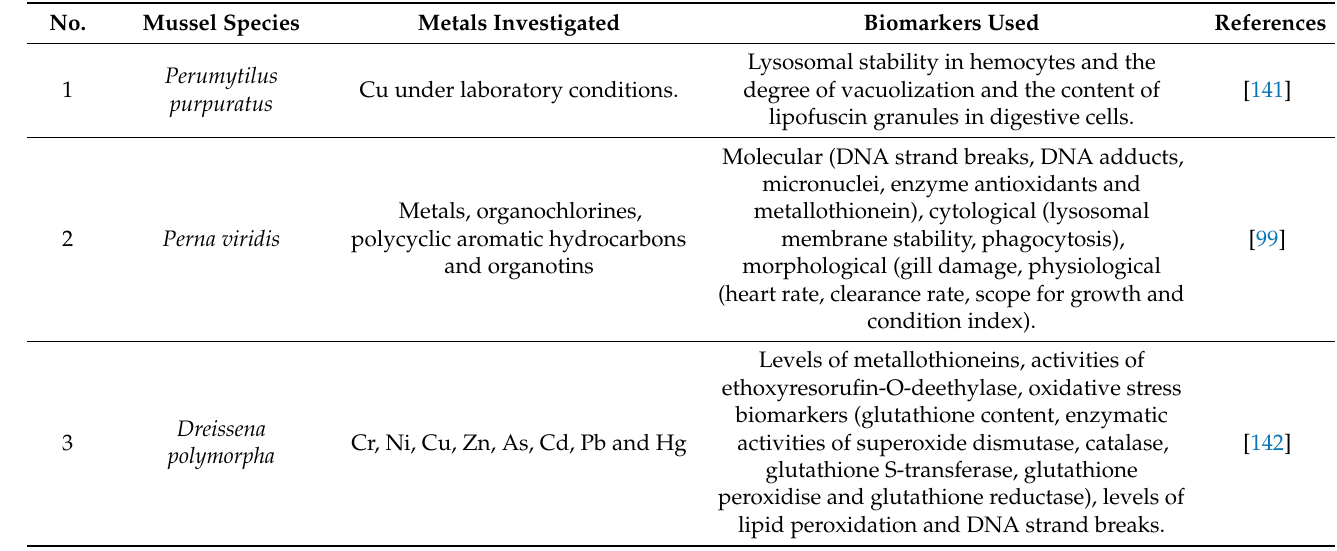
Table 3. A review on the use of bivalves’ biomarkers in metal pollution studies on bivalves from some of the available literature. No. Mussel